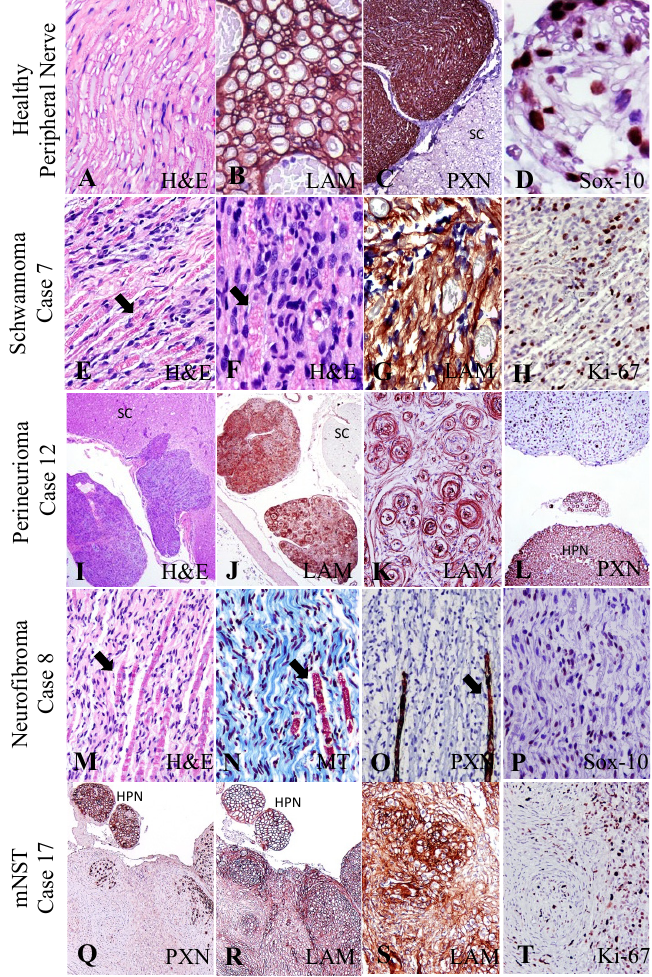
Figure 1. Optimization of peripheral nerve markers in positive control tissue. ( A , E , F , I , J , M ): The distinct morphology of a healthy nerve and the cells and tumor histogenesis of NST can be appreciated on H&E-stained tissue sections. ( B , R ) Laminin (LAM) immunoreactivity highlights the cytoplasmic Schwann cell membranes outlining the myelin sheath of healthy peripheral nerves (HPN). Confirmation by laminin (LAM) of basal lamina of cytoplasmic membranes in a Schwannoma ( G ), perineurioma ( J , K ) and mNST ( R , S ). Periaxin (PXN) detects peripheral myelin only. Note that the spinal cord (SC) is negative, while the spinal nerve root is strongly positive in healthy nerves ( C ) and in NST ( L , Q ). In the case of neurofibromas, Masson’s trichrome (MT) identifies the collagenous tumor stroma in blue ( N ) and PXN identifies nerve fibers entrapped within the tumor ( O ). ( E , M – O ) Arrows point at retained nerve fibers within NST. ( Q – S ) Neoplastic areas of a mNST have weak PXN and robust LAM immunoreactivity. Sox-10 directed to nuclei of Schwann cells identifies peripheral nerves ( D ) and neoplastic Schwann cells ( P ). Ki-67 immunolabels nuclei of neoplastic cells that are actively proliferating ( H , T